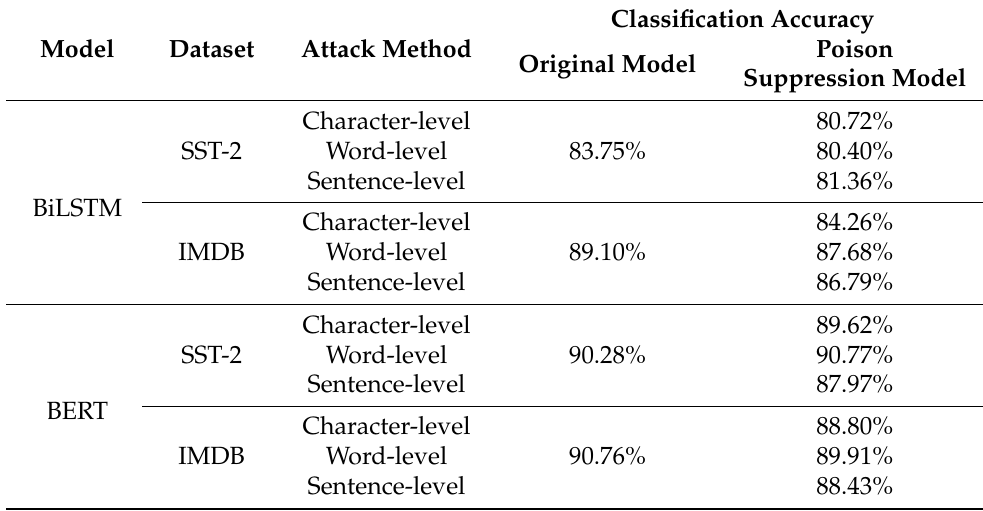
Table 7. Classification accuracy of the poisoning suppression model and the original